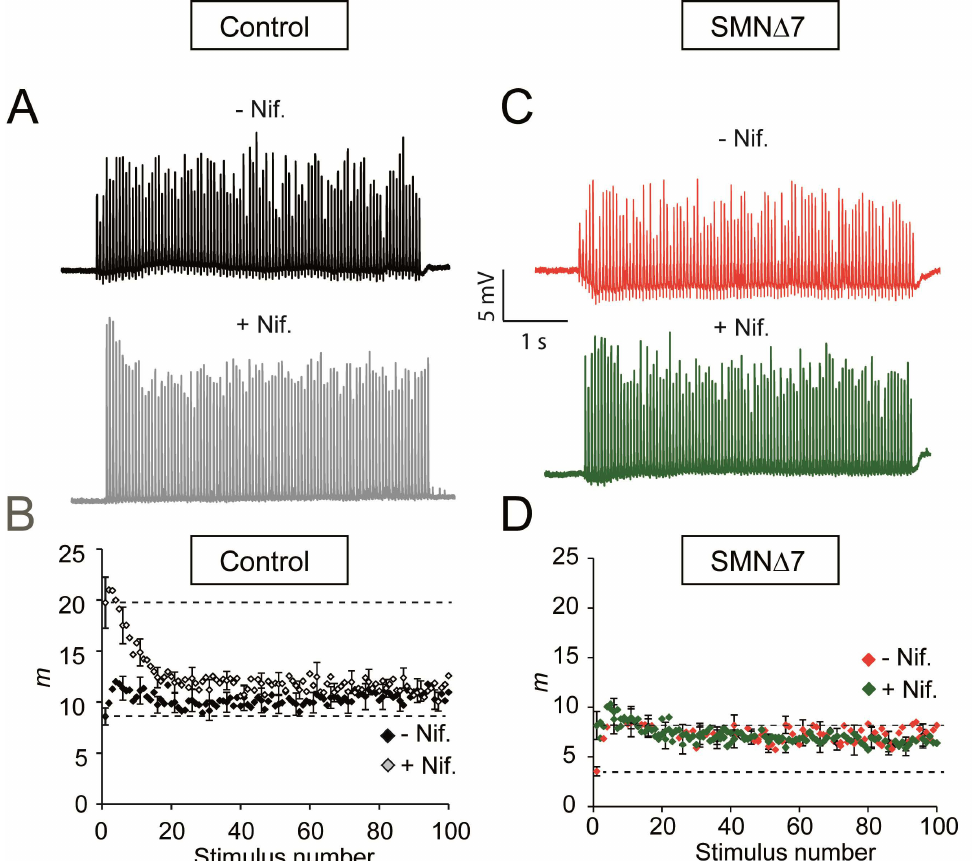
Figure 4. Nifedipine does not increase the size of the RPP in the SMA terminals. ( A , C ) Representative examples of EPP recordings during 20 Hz, 5 s trains in control ( A ) and SMA ( C ) terminals before and after the application of nifedipine. ( B , D ) Mean quantum content ( m ) in control ( B ) and SMA ( D ) mice in the absence and presence of